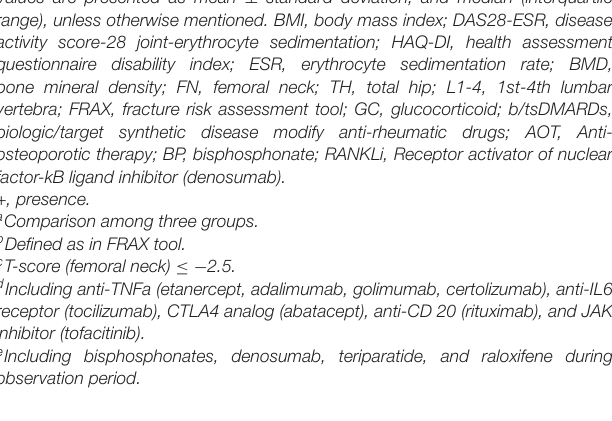
biologic/target synthetic disease modify anti-rheumatic drugs; AOT, Anti- osteoporotic therapy; BP, bisphosphonate; RANKLi, Receptor activator of nuclear factor-kB ligand inhibitor (denosumab). +, presence. a Comparison among three groups. b Defined as in FRAX